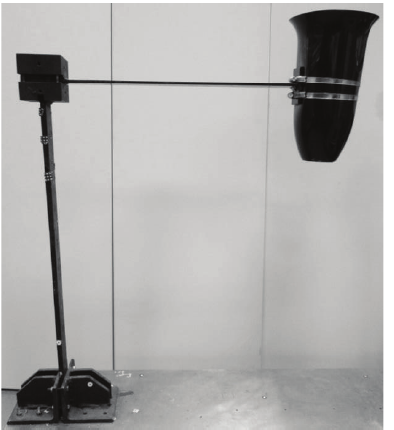
Figure 11: Experimental time-variant test rig.